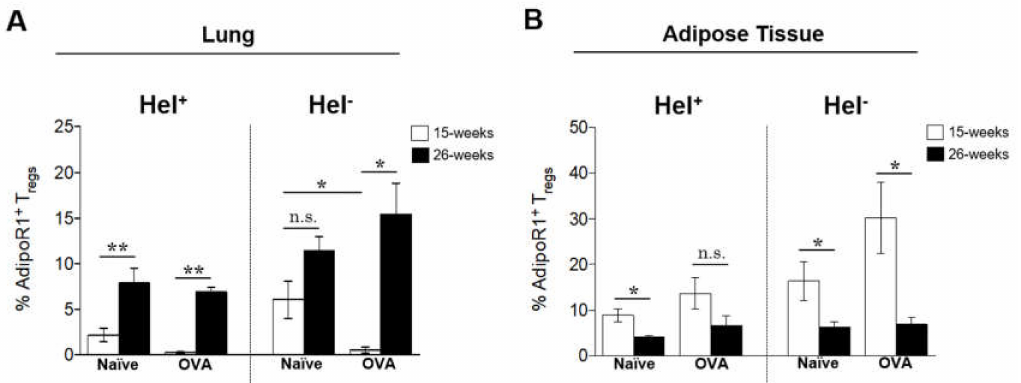
Figure 6. Lung and adipose tissue AdipoR1 + Tregs were di ff erentially regulated in the DIO-associated allergic inflammation model. ( A ) AdipoR1 expression in lung Helios + and Helios − Foxp3 + Tregs in naïve and allergic DIO mice on HFD at 15 weeks (overweight) and 26 weeks (morbid obesity) of age. ( B ) AdipoR1 expression in adipose tissue Helios + and Helios − Foxp3 + Tregs in DIO naïve and allergic mice. AdipoR1 + population gated within CD3 + CD4 + Foxp3 + Helios + or CD3 + CD4 + Foxp3 + Helios − cells. Data are means ± SEM of n = 3–4 mice per group. One-way ANOVA followed by Bonferroni’s multiple comparisons test, * p < 0.05, and ** p < 0.01. DIO, diet-induced obesity; HFD, high-fat diet; OVA, ovalbumin; AdipoR1, adiponectin receptor 1; Tregs, regulatory T cells; and Hel,